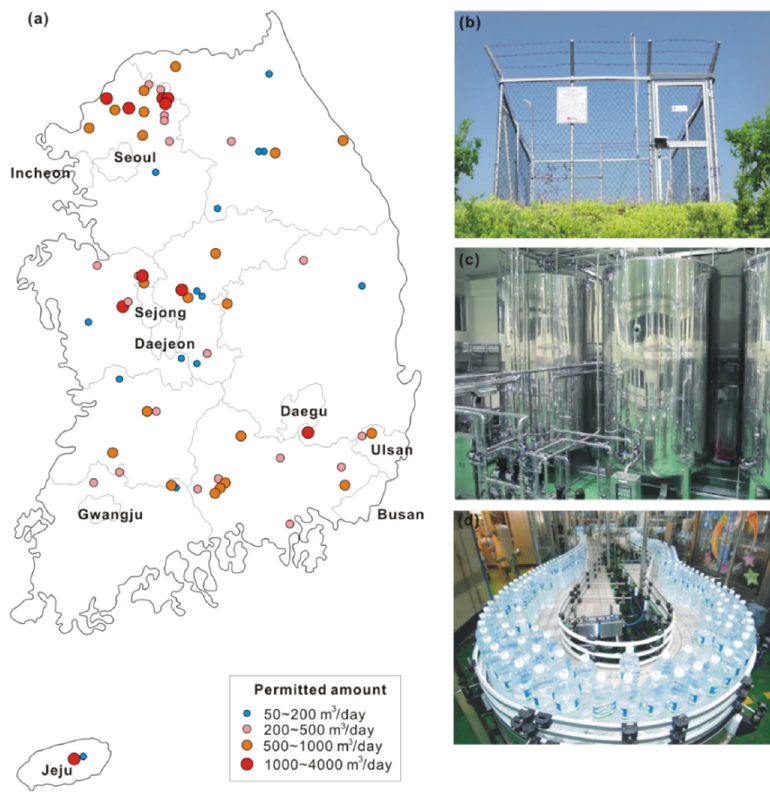
Figure 7. ( a ) Distribution of groundwater wells used for manufacturing bottled drinking water with permitted withdrawal amount [48]; ( b ) one of the pumping wells; ( c ) physical filtration process for pumped groundwater; and ( d ) automated bottling line facility.